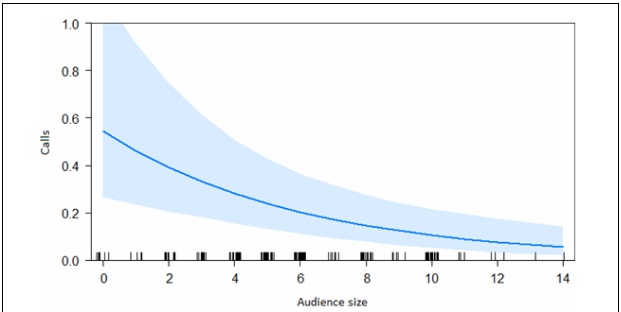
FIGURE 2 | Effect of audience size on the number of calls when finding the snake (Audience size = Number of individuals around 10 m of the subject). Calls: Proportion of alarm calls given by the subject.